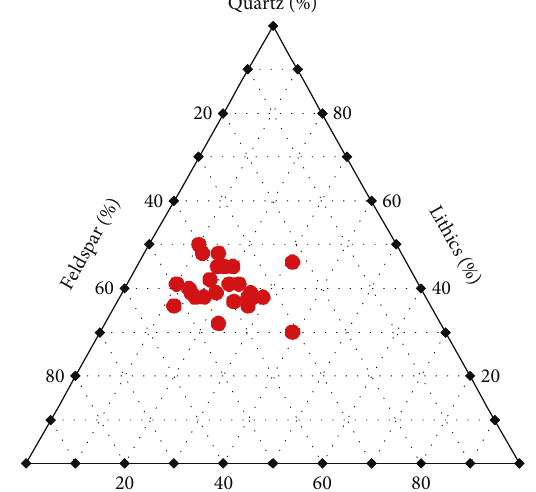
Figure 2: Rock classi fi cation of rock samples from the slope of Mahu